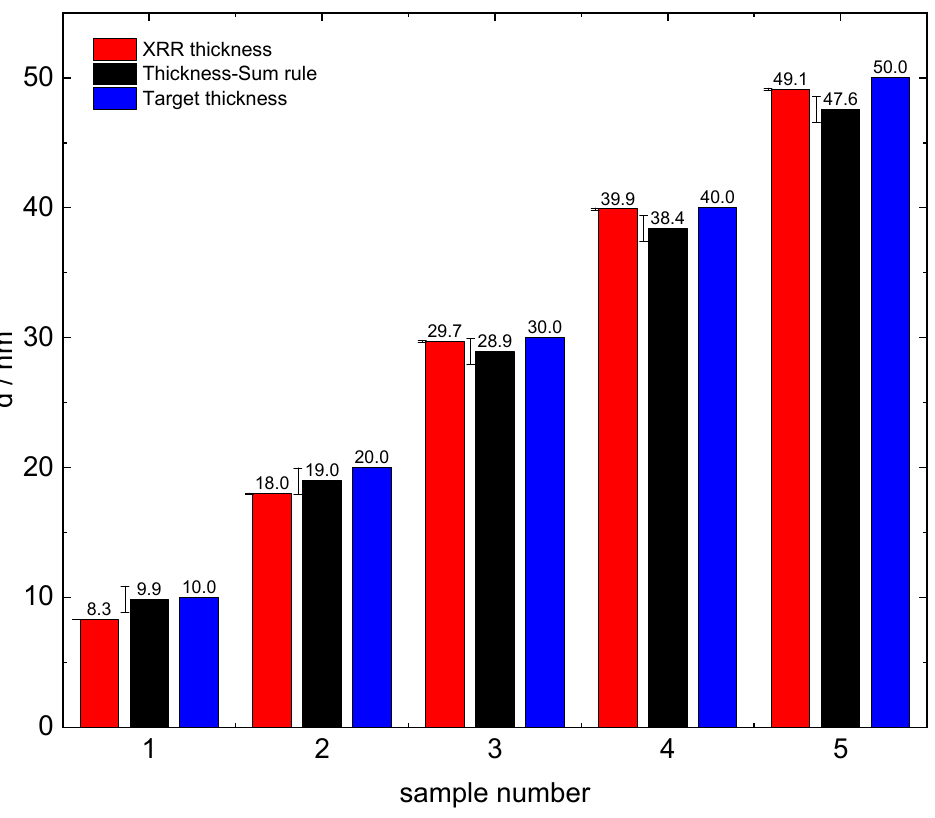
Figure 3. Geometrical thicknesses of aluminum layers prepared by sputtering (series 1). Sample numbers corresponding to the order of samples in Table 4.